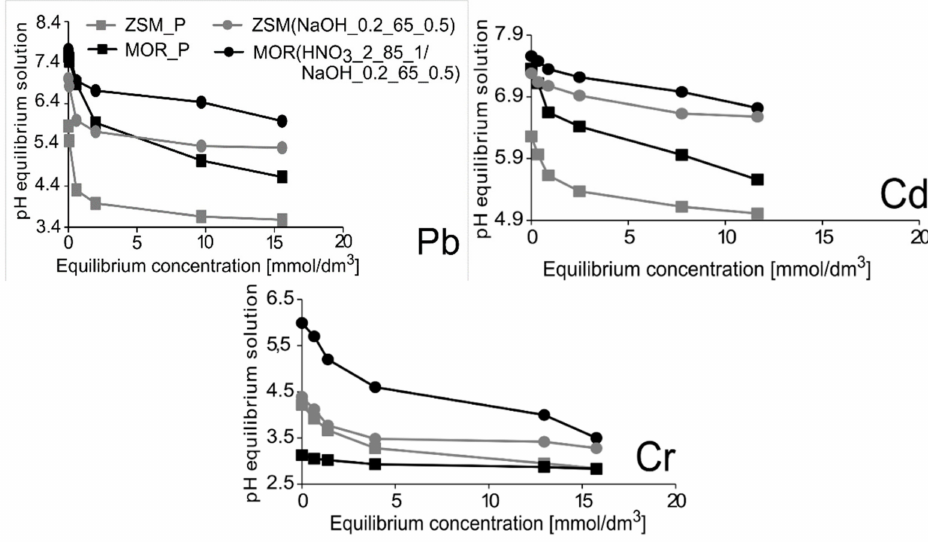
Figure 7. Results of pH values of equilibrium solutions with respect to equilibrium concentration of solutions containing heavy metal